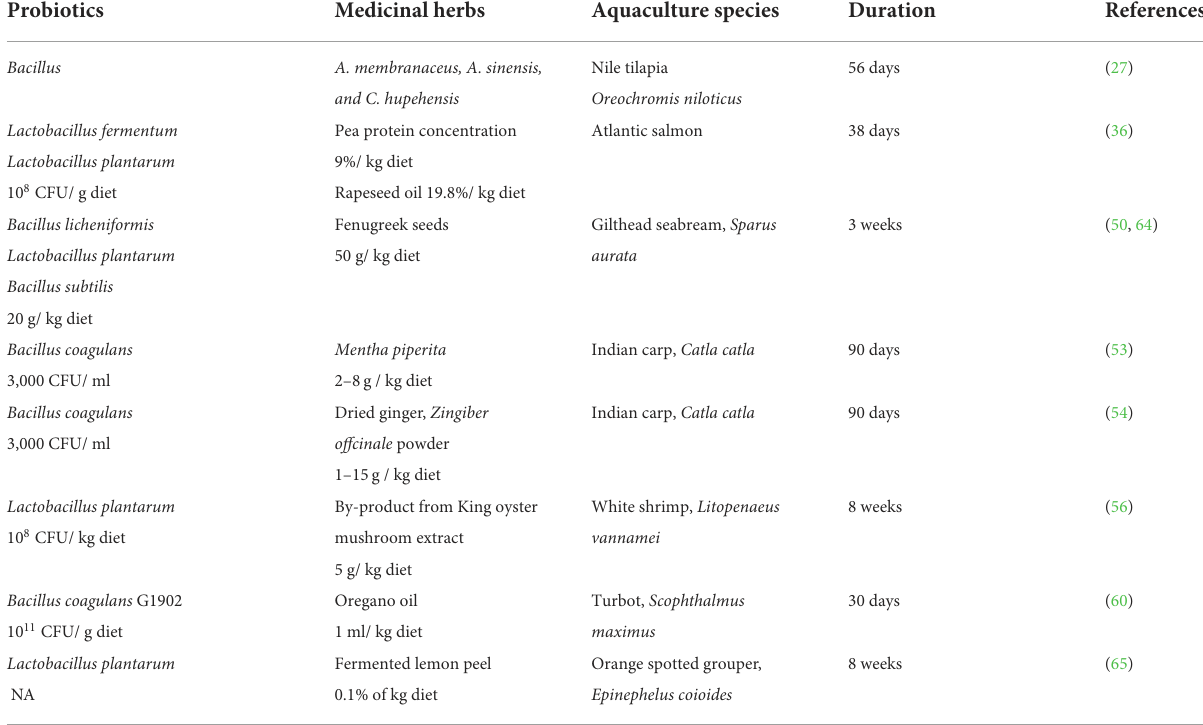
TABLE 3 Application of probiotic and medicinal herb combination in improving immune system of aquatic animals. Probiotics